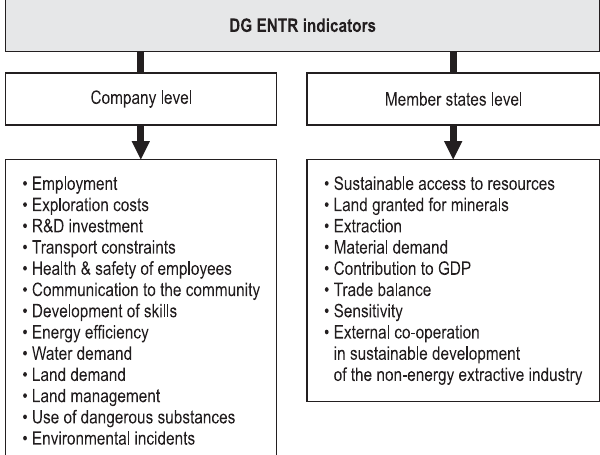
Fig. 7. Directorate’s-General for Enterprise ( DG ENTR ) classifi cation of Sustainable development indicators. Source: DG ENTR